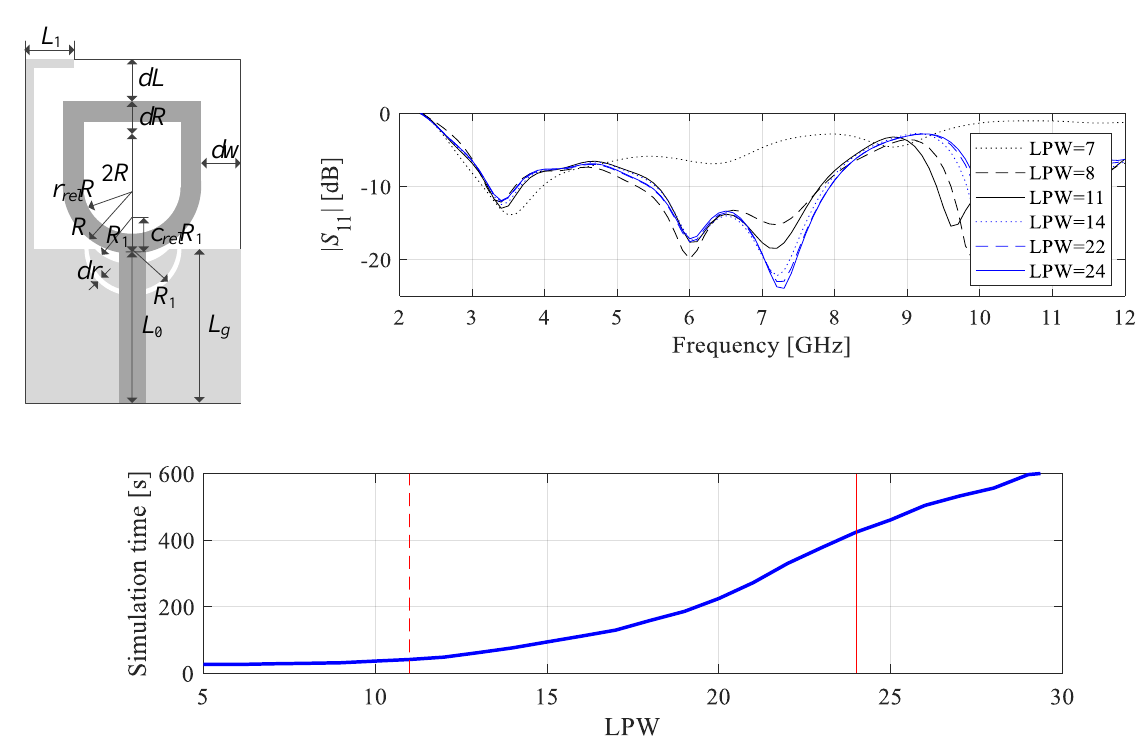
Figure 1. Multi-fidelity simulation models for an exemplary broadband monopole antenna [76]. The picture shows the antenna geometry, the family of reflection characteristics for several discretization densities of the structure (controlled using the lines-per-wavelength parameter LPW), and the simulation time versus LPW (averaged over several antenna geometries). The mesh densities corresponding to the high-fidelity model and the lowest usable low-fidelity one are marked using the vertical lines, solid and dashed, respectively.